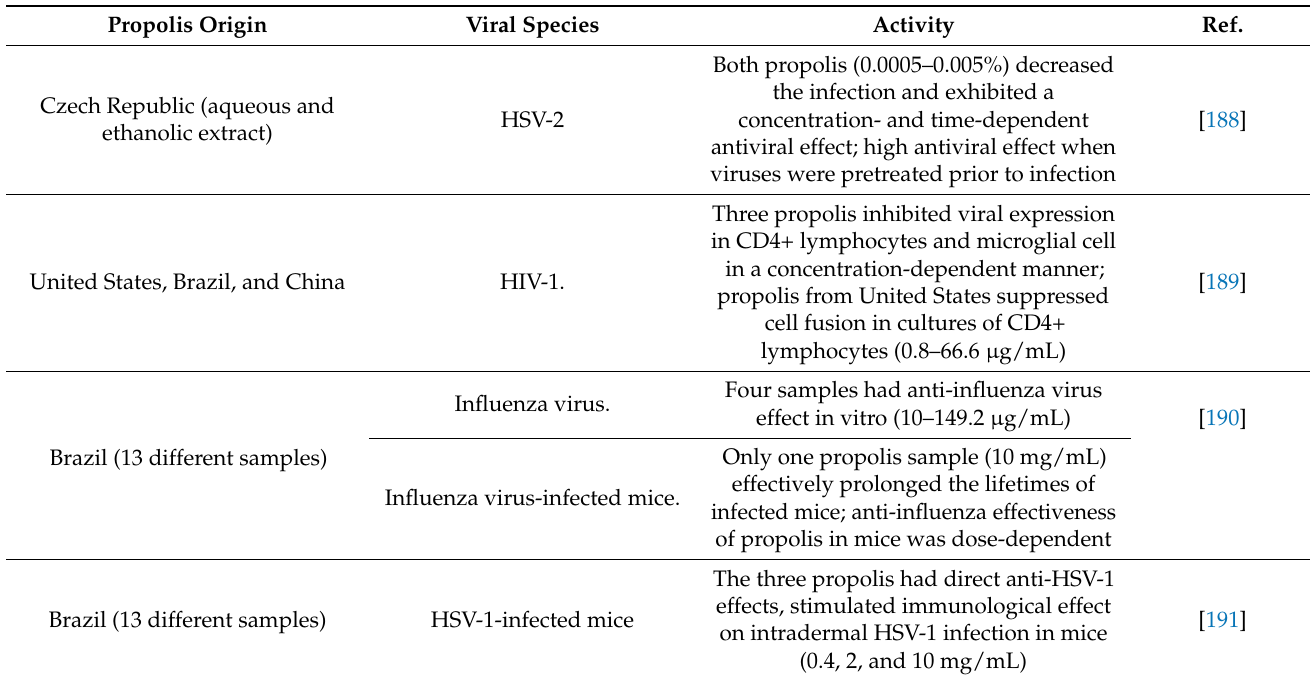
Table 17. Antiviral activity of different samples of propolis.